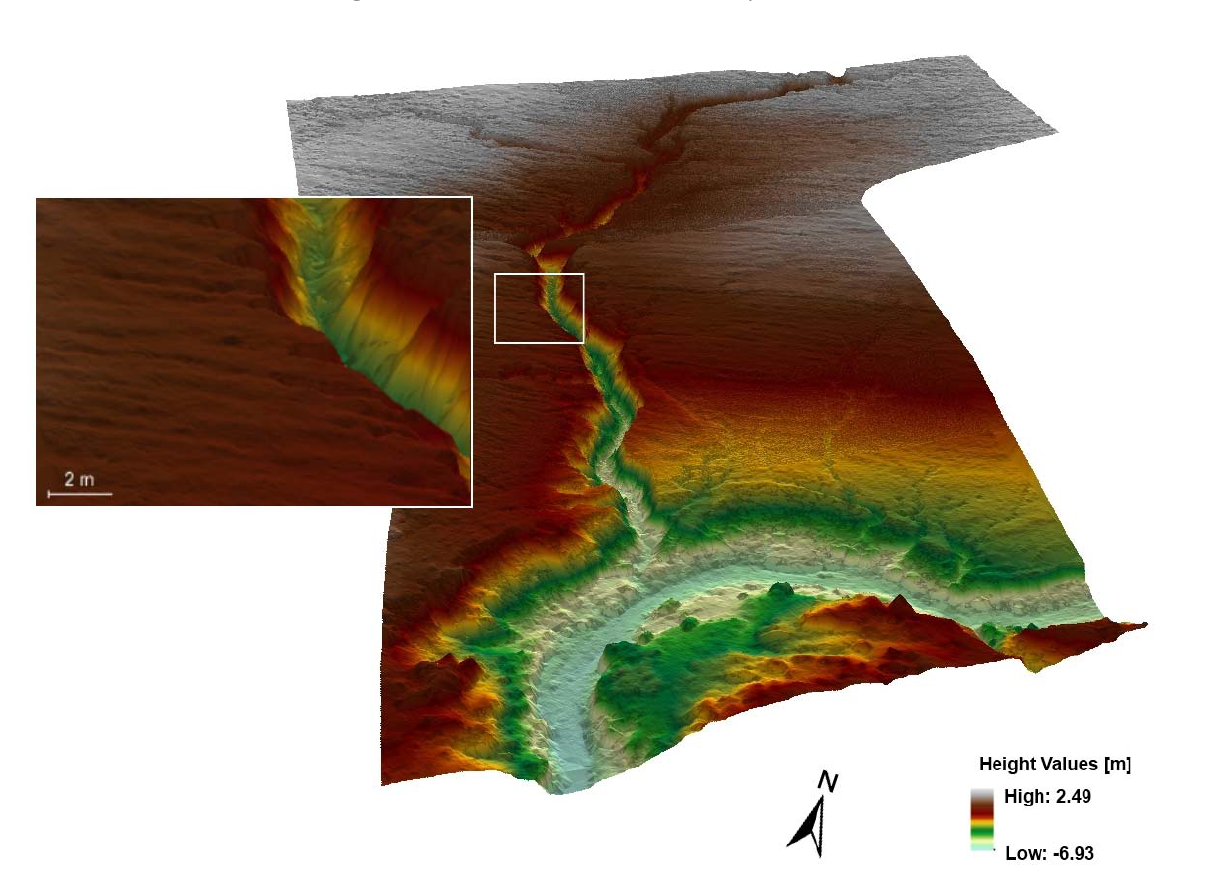
Figure 11. Generated DTM of study site